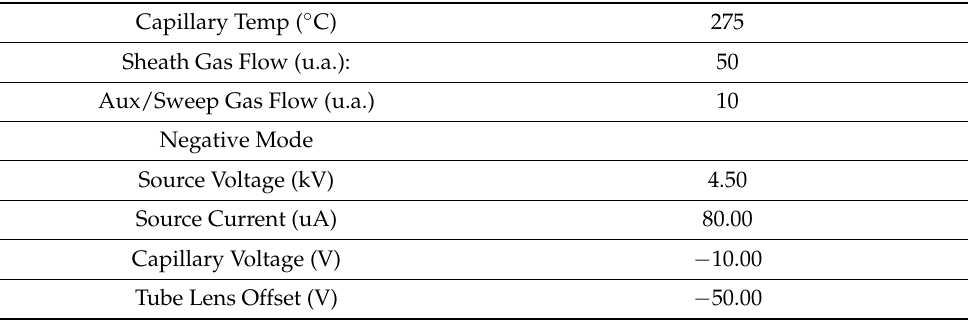
Table 1. Ionisation parameters used for mass spectrometry detection of C29. Capillary Temp ( ◦ C) 275 Sheath Gas Flow